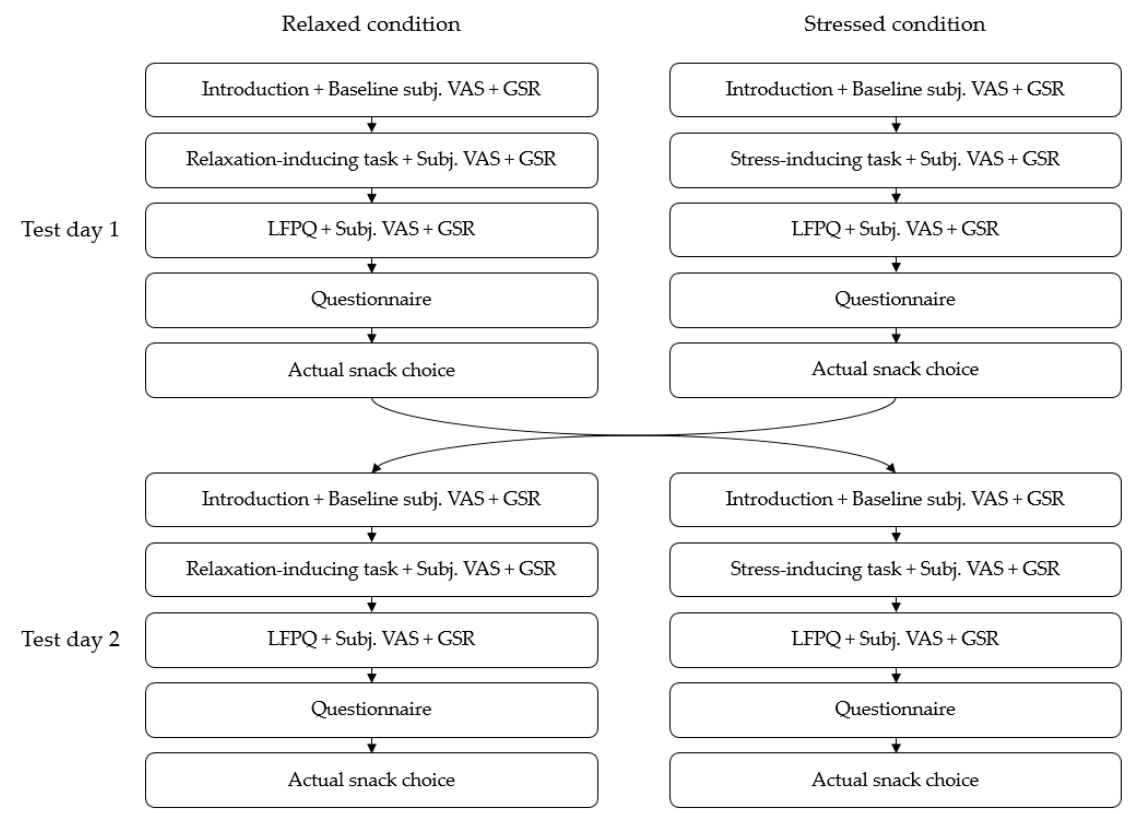
Figure 1. Flowchart of experimental procedure. The study followed a randomized controlled trial design, where each participant completed the Leeds Food Preference Questionnaire twice—once after completion of the relaxation-inducing task, and once after completion of the stress-inducing task. Subjective measures by visual analogue scales, GSR, a self-report questionnaire and actual snack choice was likewise recorded for both test days.